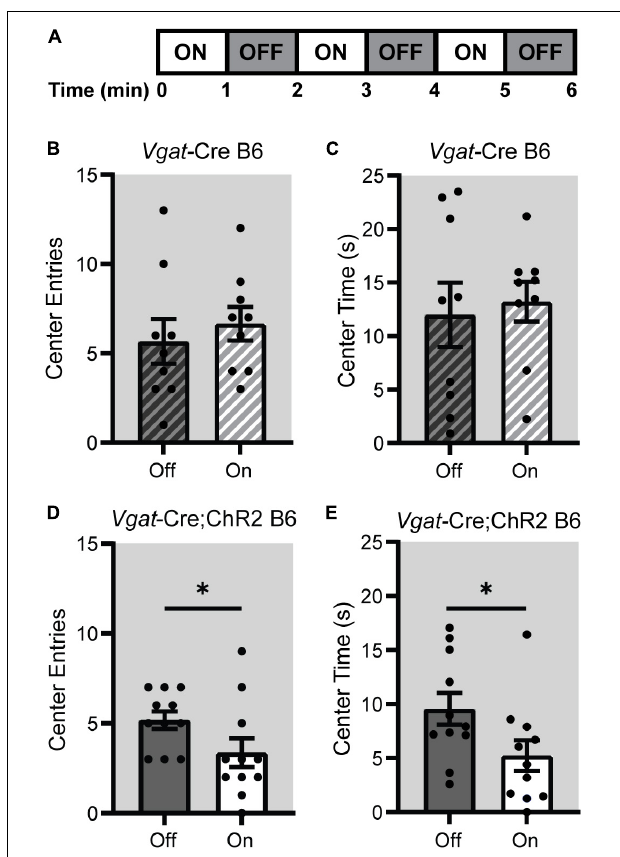
FIGURE 6 | Acute optogenetic stimulation of the SCN during the dark phase increased anxiety-like behavior in the OF. (A) Male and female Vgat -Cre;ChR2 B6 or Vgat -Cre B6 control mice received blue light pulses (8 Hz, 10 ms pulse width) in alternating 1 min blocks for a total of 3 min while in the OF. (B) Acute SCN stimulation at ZT14-16 had no effect on center entries or (C) total time spent in the center of Vgat -Cre B6 mice in the OF. (D) In Vgat -Cre;ChR2 B6 mice, acute SCN stimulation at ZT14-16 decreased the number of center entries in the OF and (E) decreased total time spent in the center time relative to the laser off periods. n = 9–11. ∗ p <